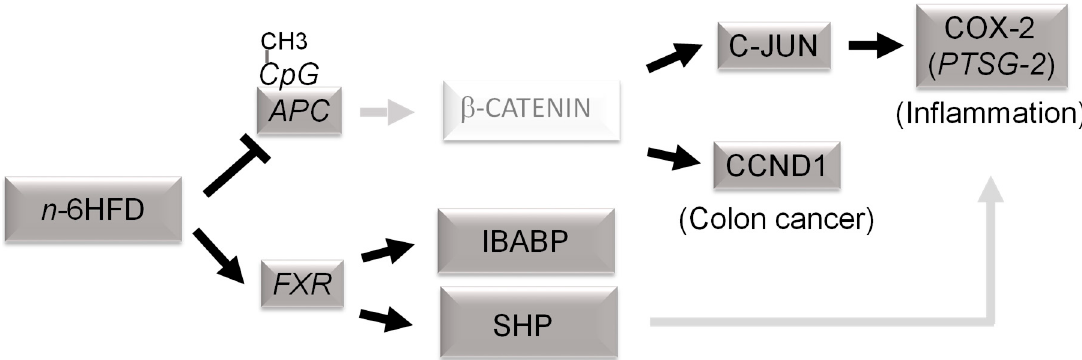
Figure 6. Proposed epigenetic model of colonic inflammation and carcinogenesis associated with long-term exposure to a diet high in n -6 fatty acids ( n -6HFD). Chronic exposure to an n -6HFD impairs adenomatous polyposis Coli ( APC ) expression through CpG hypermethylation (CpG-CH 3 ). This favors the activation of downstream targets of the β -catenin/Wnt pathway, supporting increased expression of genes involved in inflammation (c-JUN, PTSG-2 ) and proliferation such as cyclin D1 (CCND1). The factors in dark grey boxes refer to changes in expression from the current study. The involvement of β -catenin and upregulation of cyclooxygenase-2 (COX-2) by small heterodimer protein (SHP) are suggested based on published studies mentioned in the Discussion. FXR = farnesoid-X-receptor; IBABP = ileal bile acid-binding protein.